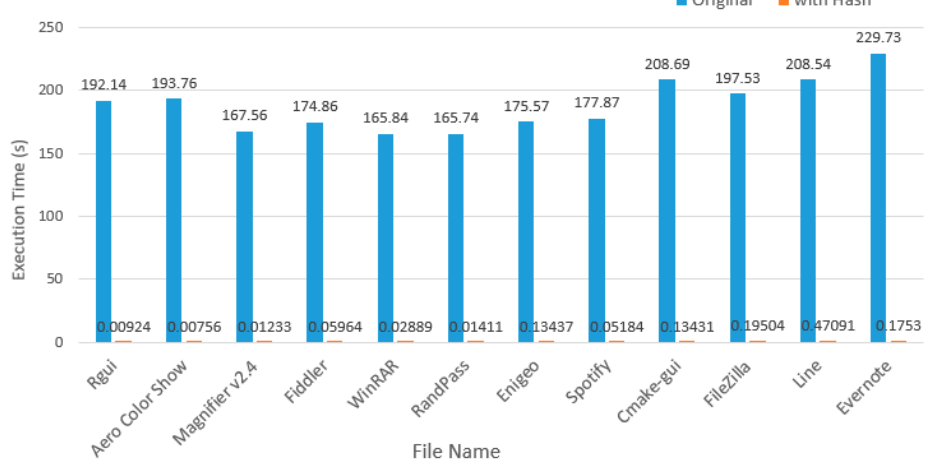
Figure 6. Total preparation time of an executable when the executable is first executed and total preparation time of the executable when it has been executed.